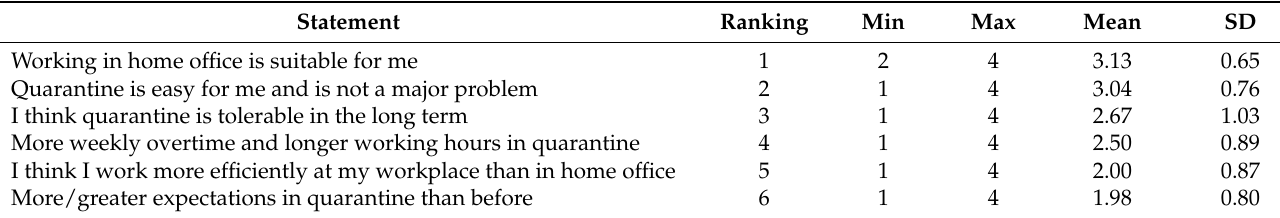
Table 2. Working in quarantine (N = 46).